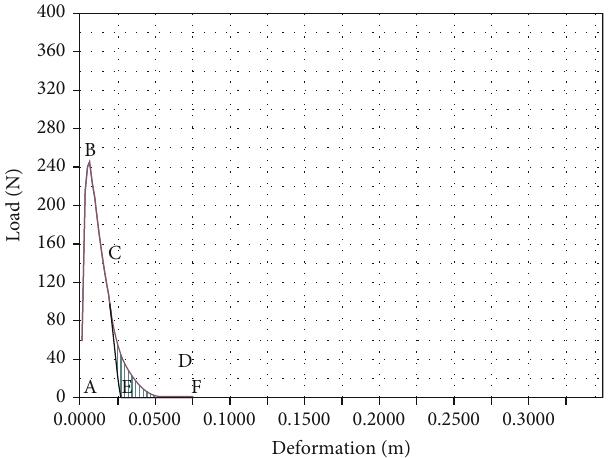
Figure 7: 90# matrix asphalt viscosity test load-deformation